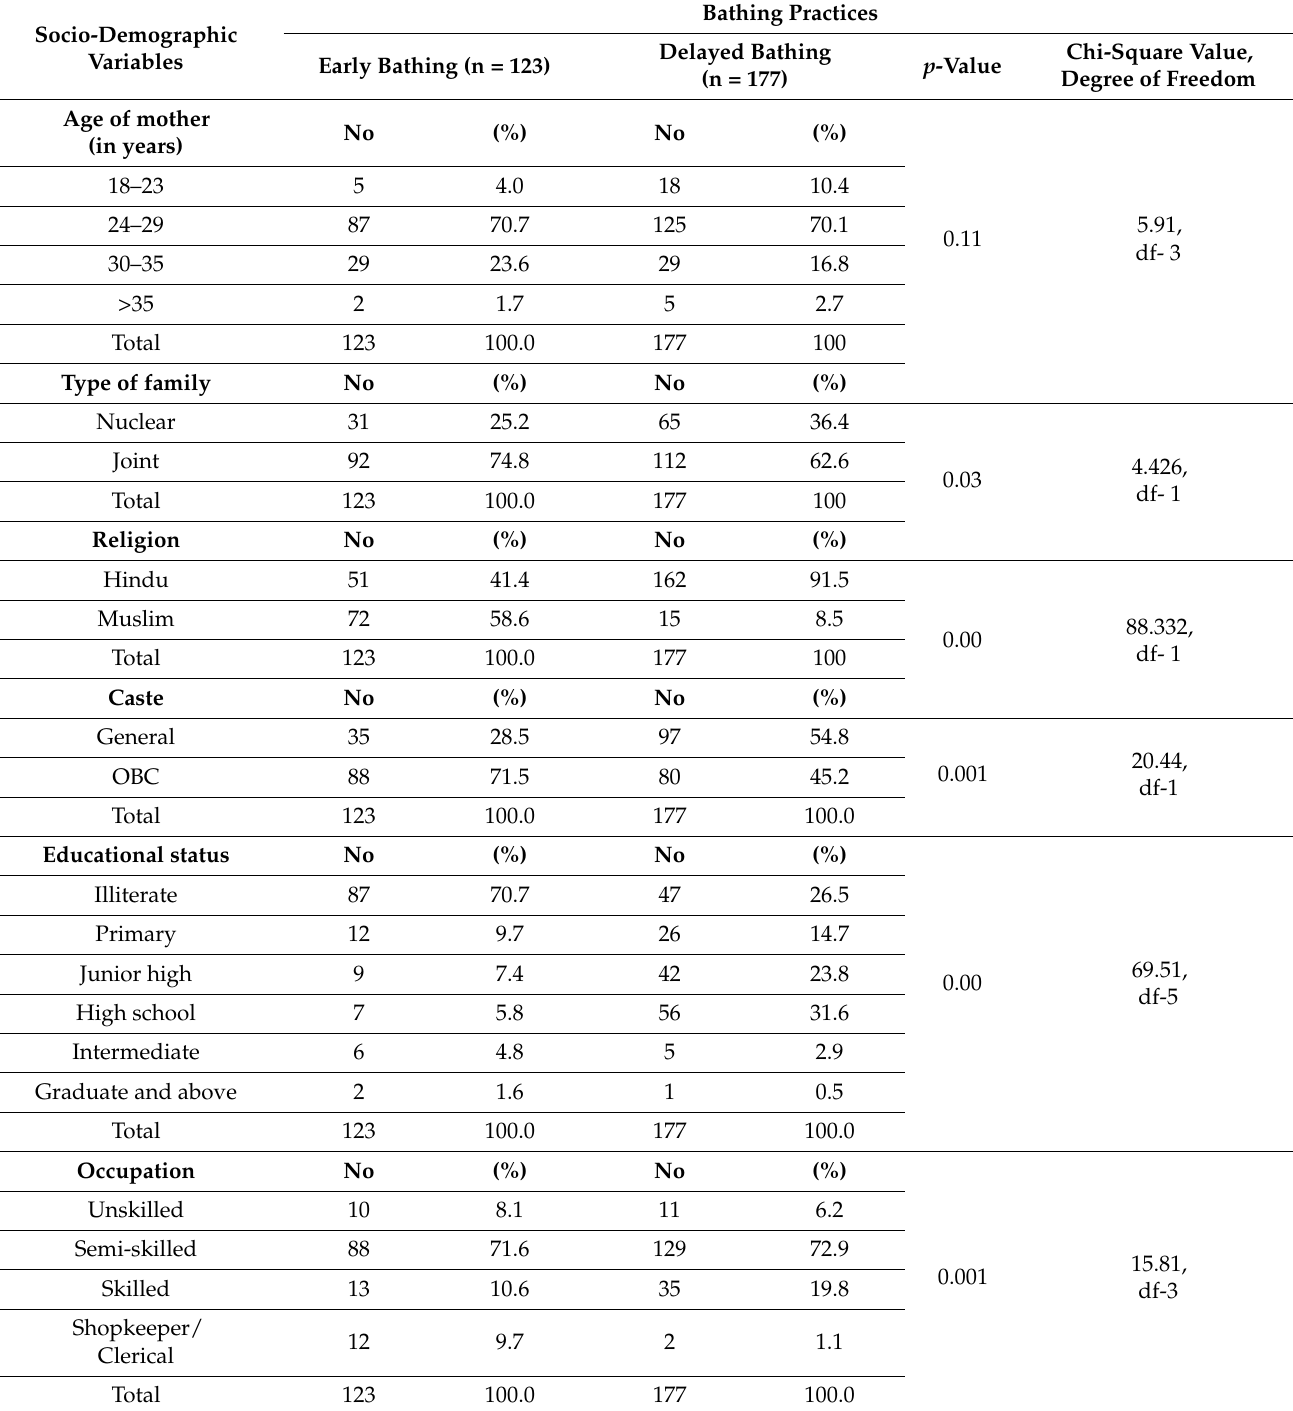
Table 5. Socio-demographic factors influencing new-born bathing